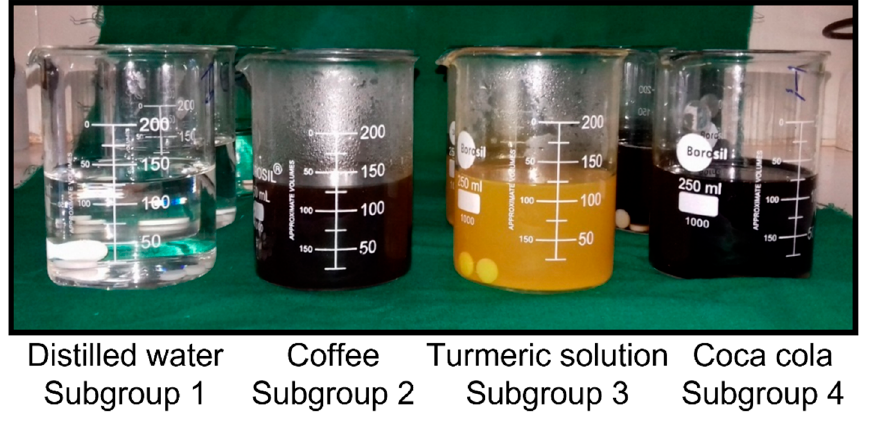
Figure 3. Specimens immersed in staining solutions.